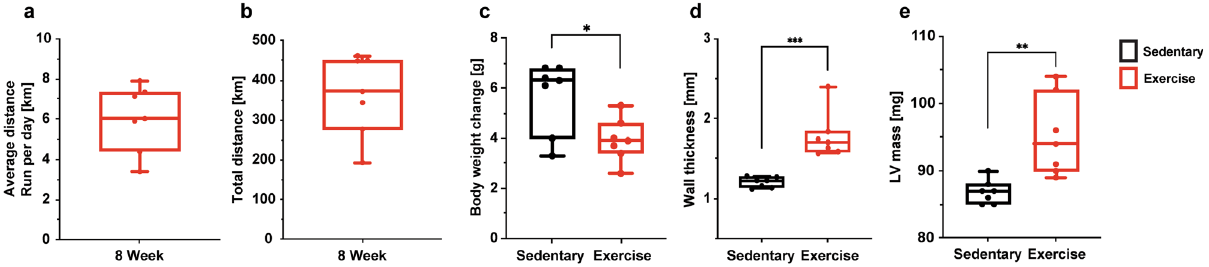
Fig. 2 Wheel running promotes signi fi cant changes in body weight, heart mass, and thickness. a The average distance cohort 1 ran per day in kilometers (km). b The average total km cohort 2 ran through 8-weeks. c The body weight changes between the sedentary and exercise groups of cohort 1. d The difference in wall thickness between the sedentary and exercise groups of cohort 1. e The difference in left ventricular (LV) mass between the exercise and sedentary groups. Unpaired two-tailed t -test * P < 0.05, ** P < 0.01, *** P < 0.001. Data are presented min to max. Within each box, horizontal black and red lines denote median values; boxes extend from the 25th to the 75th percentile of each group ’ s distribution of values.